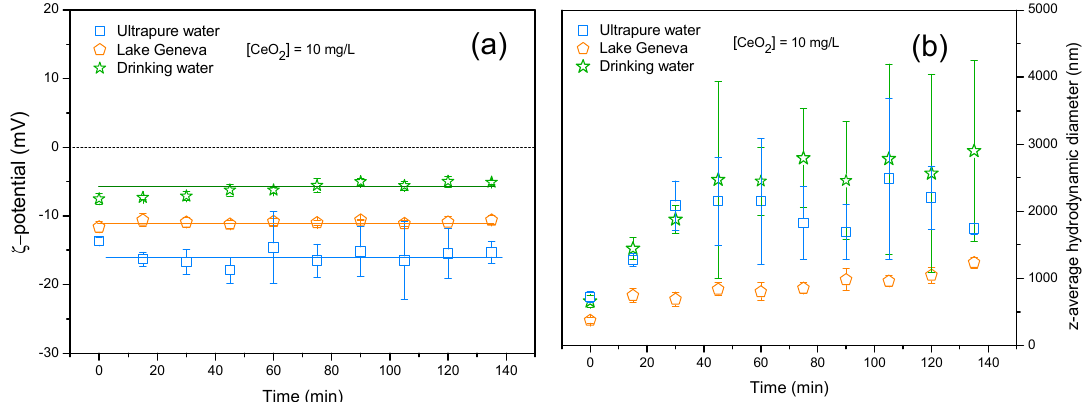
Figure 7. ( a ) ζ potential and ( b ) z-average hydrodynamic diameter variation of CeO 2 as a function of time in ultrapure water at pH = 8.0 ± 0.1, drinking and Lake Geneva waters at their natural pHs. Limited aggregation is observed due to the presence of DOC at a significant concentration (1.12 mg / L) when CeO 2 NPs are introduced in Lake Geneva water.